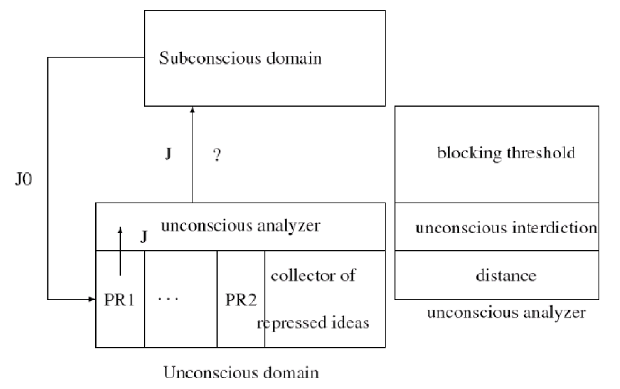
Figure 5. Interference of an idea-attractor with the domain of hidden forbidden wishes. Internal structure of the unconscious analyzer.